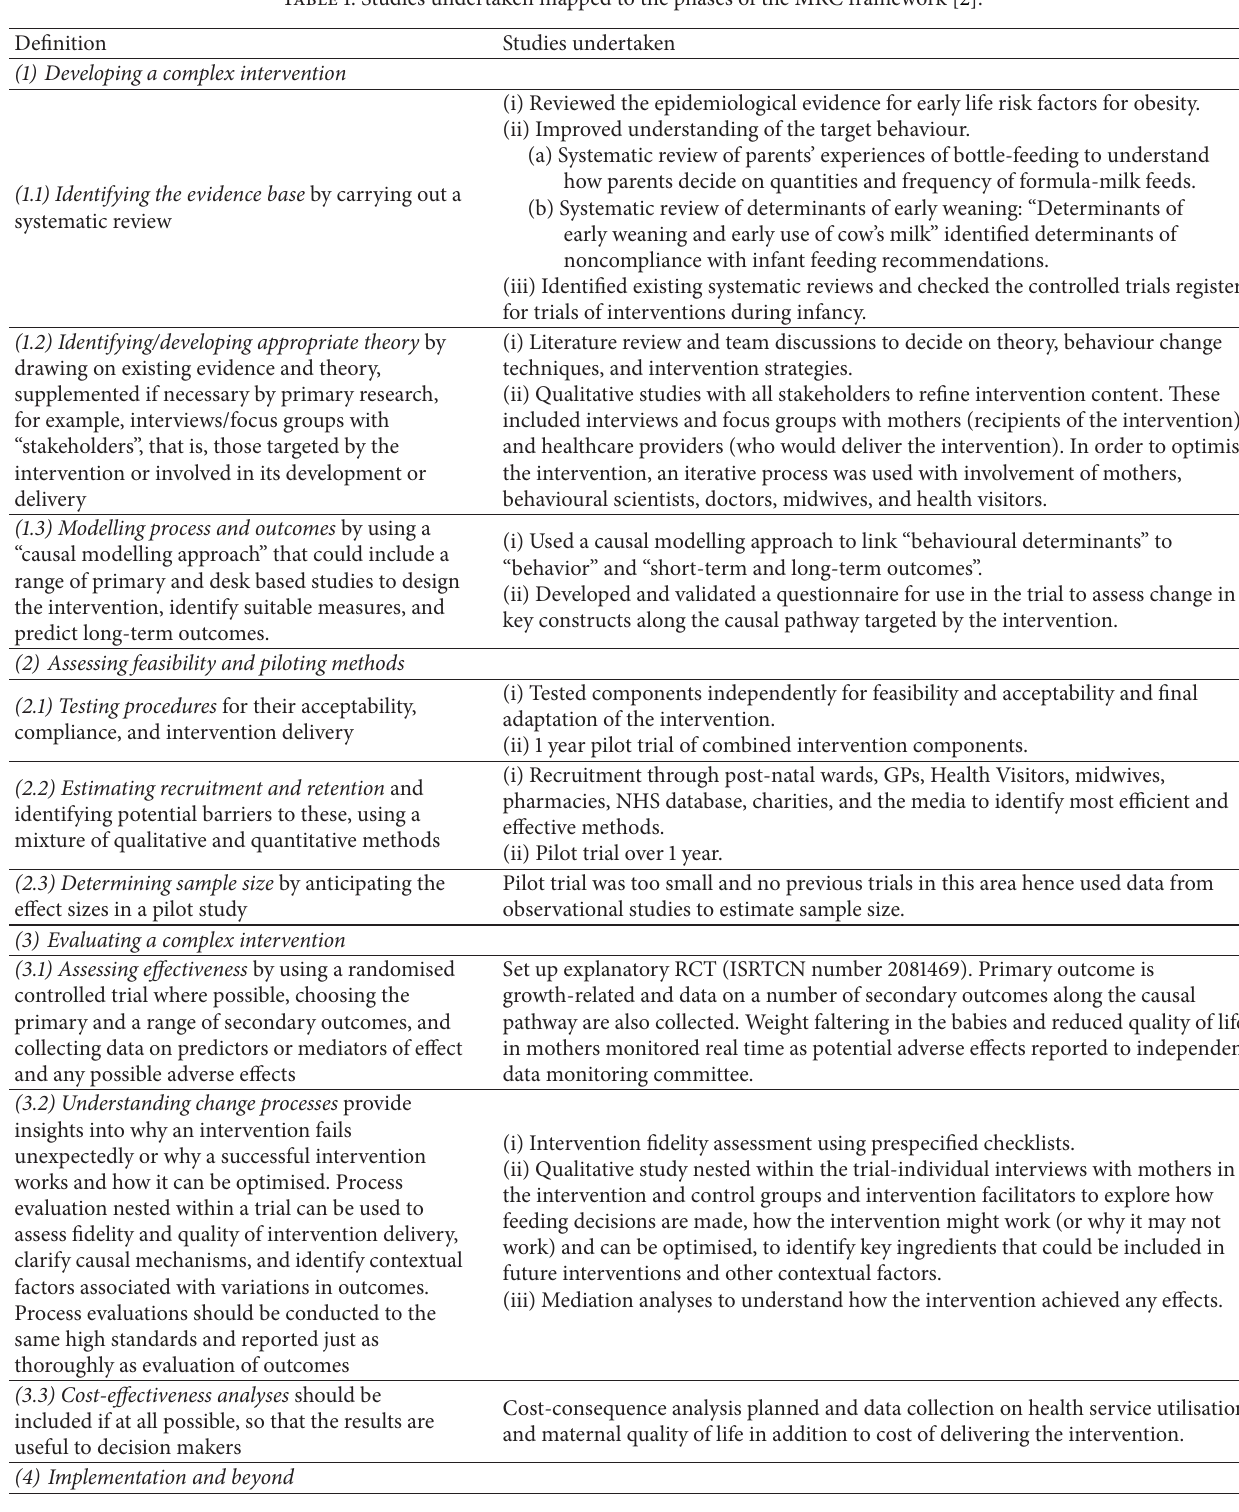
Table 1: Studies undertaken mapped to the phases of the MRC framework